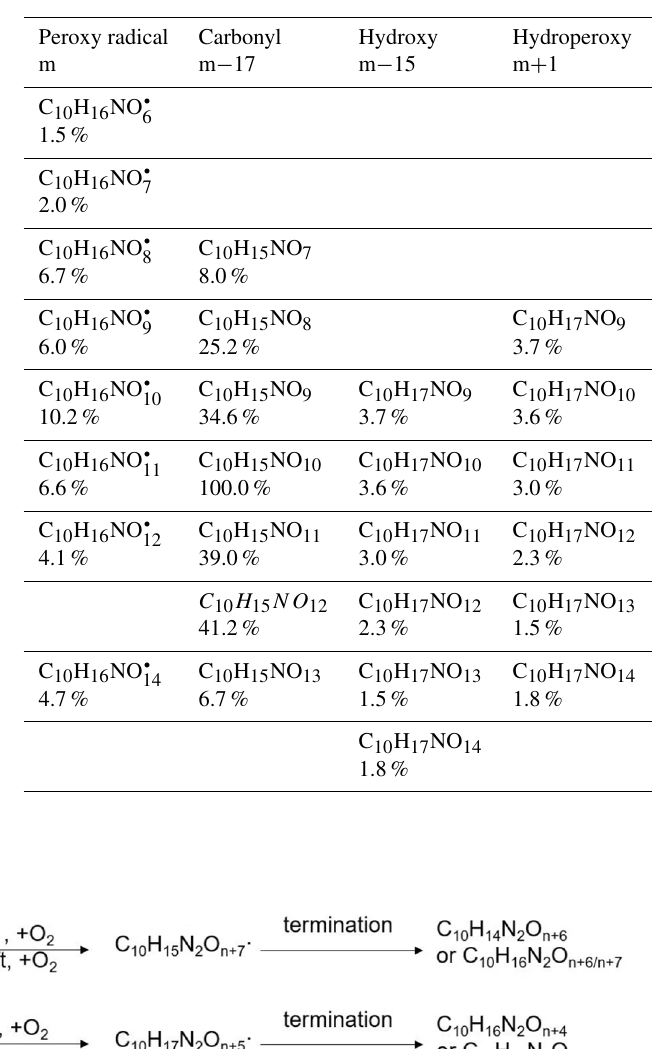
− 17), hydroxyl compounds